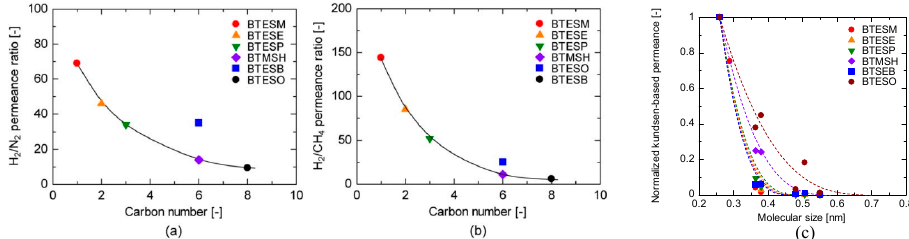
Figure 6. The permeance ratios of ( a ) H 2 /N 2 and ( b ) H 2 /CH 4 at 200 °C; ( c ) pore size prediction based on a NKP method as a function of the number of carbon linking units. Reproduced from [15] in context and supporting information.